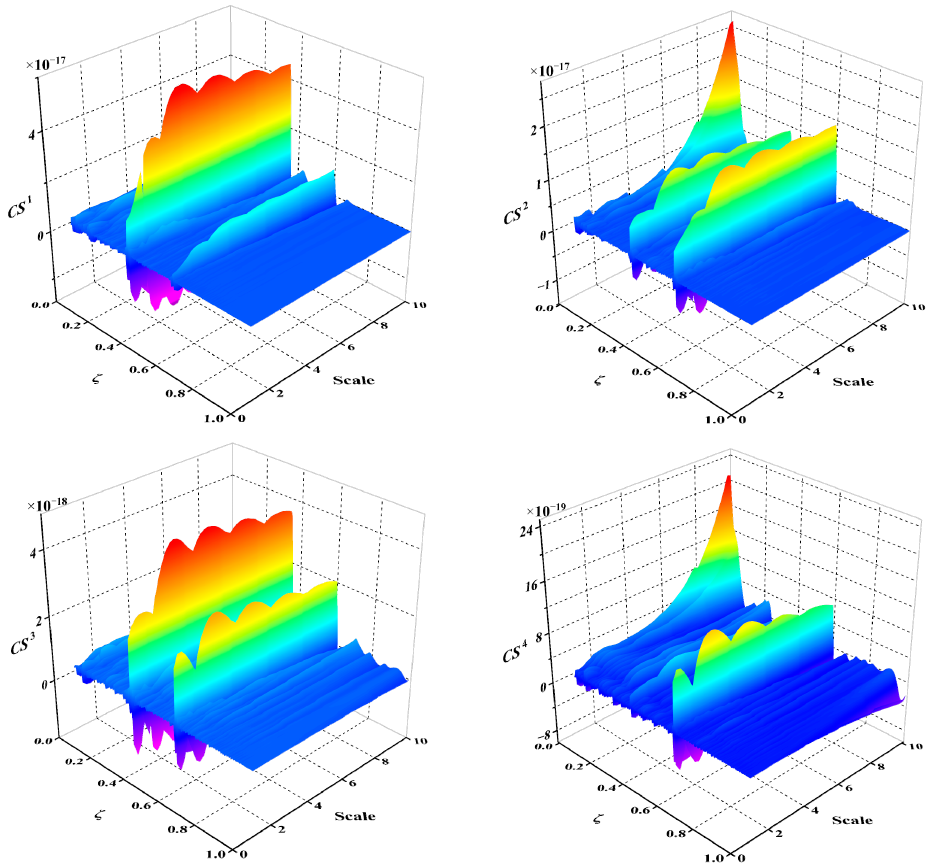
Figure 21. CS ( b , s ) of scenario I under impulsive load when γ = 10%.